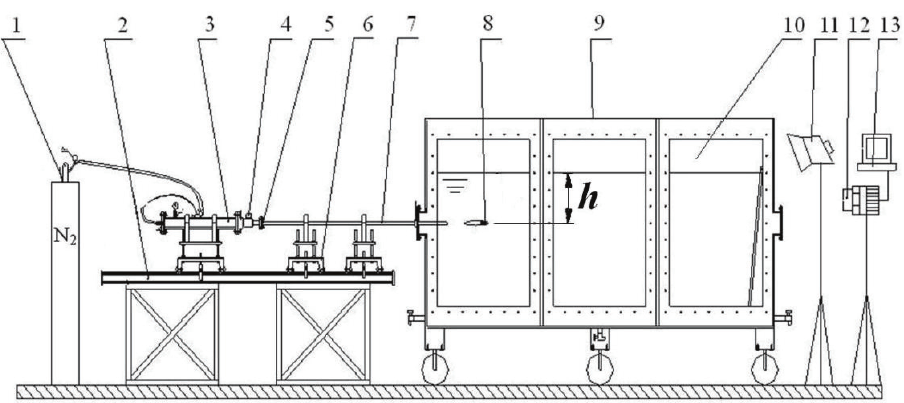
Figure 1. Schematic diagram of the horizontal supercavitation experiment